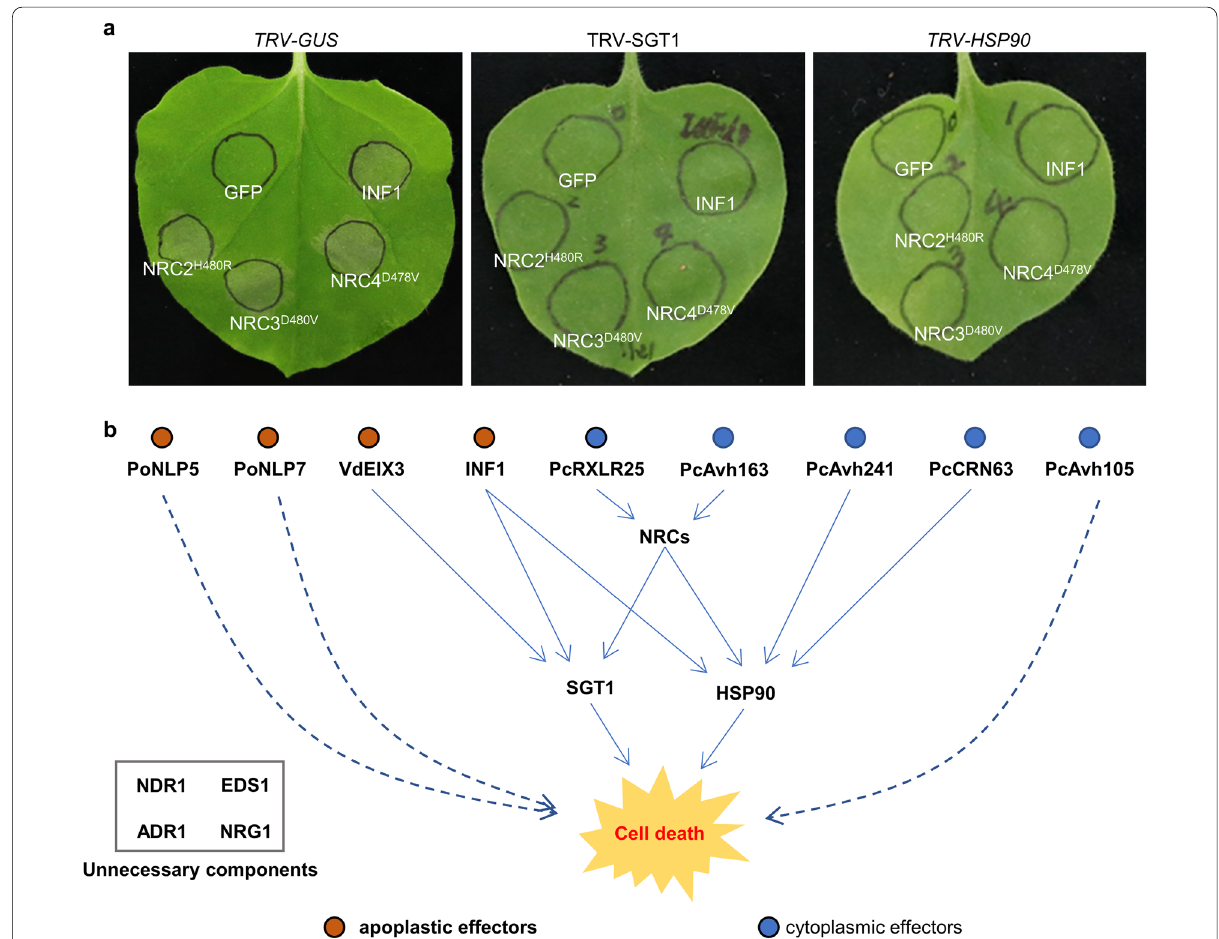
Fig. 6 Correct function of NRC2/3/4 requires SGT1 and HSP90. a The phenotypes of auto-activated NbNRC2, NbNRC3 and NbNRC4 in GUS -, SGT1 - and HSP90 -silenced N. benthamiana plants. Photographs were taken at 2 dpi. Numbers represent the number of leaves showing cell death out of the number of leaves analyzed. b Oomycete effectors-induced cell death is differentially dependent on effector-triggered immunity pathway components. Dotted arrows indicate that host genes required for the effector-induced cell death is